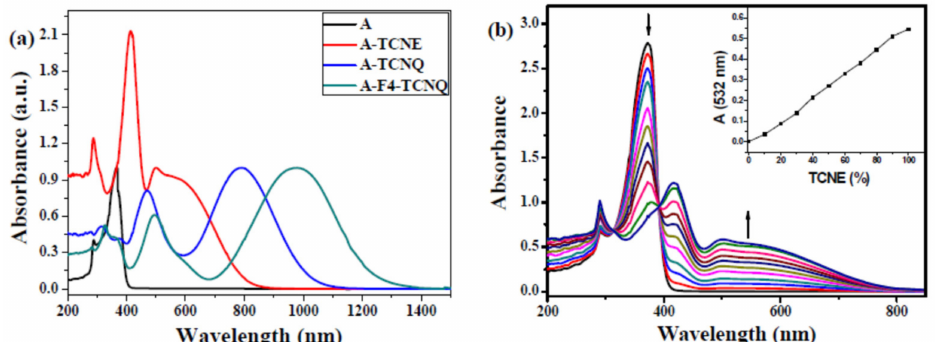
Figure 2. ( a ) Normalized UV-Vis-NIR spectra of compounds in CH 2 Cl 2 . ( b ) UV-Vis-NIR spectral change of A with the addition of TCNE reaction to the electron-rich alkyne. Inset: Plot of TCNE addition vs. absorbance increase at 532